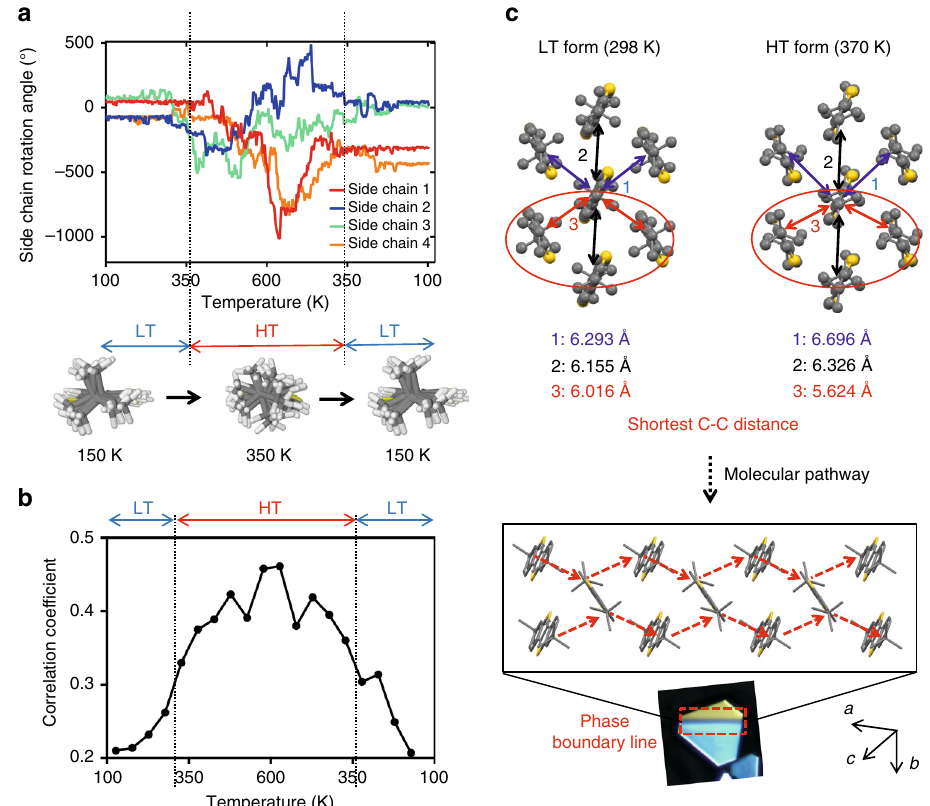
Fig. 4 Bulky side chain rotation triggers molecular cooperativity and martensitic transition. a Rotation angles of four side chains as a function of temperature from 100 → 600 → 100 K. The side chain conformations at 150 and 350 K are illustrated beneath, created by superimposing all conformations observed at the corresponding temperatures. The result indicates freely rotating side chains in the HT form. Vertical dashed lines indicate onset of fl uctuations in the side chain rotation upon heating and cooling, which match closely with the observed and measured transition temperature. b Temperature dependence of the average correlation coef fi cient between rotations of neighboring ditBu side chains. c Inferred molecular pathway for forming the phase boundary line shown in Fig. 1a Type I. The center carbon distances of the tert-butyl groups between molecular pairs were calculated from the crystal structures for both the LT and HT forms. The red arrows indicate the shortest intermolecular distance in each form. Extension along the shortest intermolecular distance for both side chains on a single molecule constitutes a possible molecular pathway that forms the phase boundary line observed